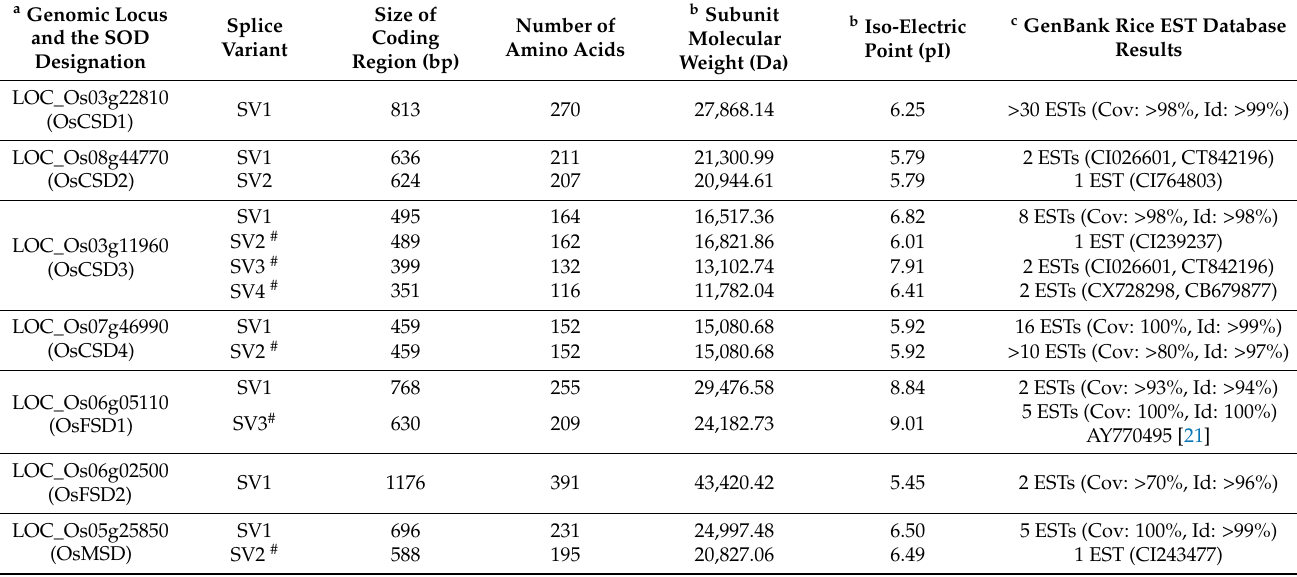
Table 1. Characteristics of coding region and predicted amino acid sequence of rice CuZn, Fe and Mn superoxide dismutases (SODs) and their splice